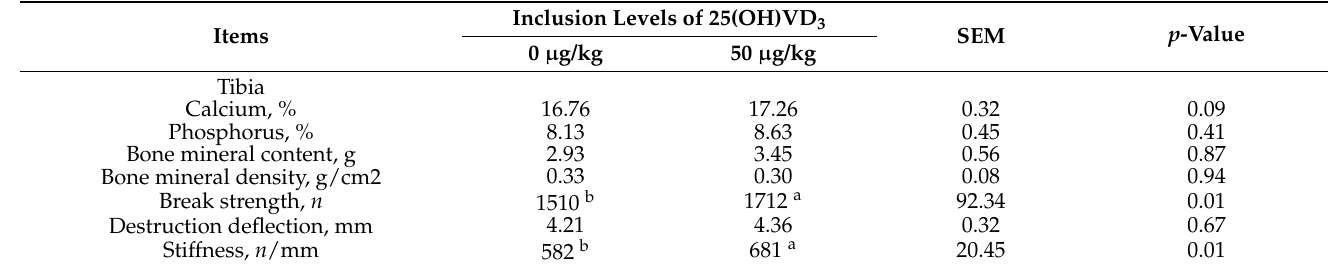
Table 7. Effects of the dietary addition of 0 and 50 µ g/kg 25(OH)VD 3 on the tibia from growing- finishing